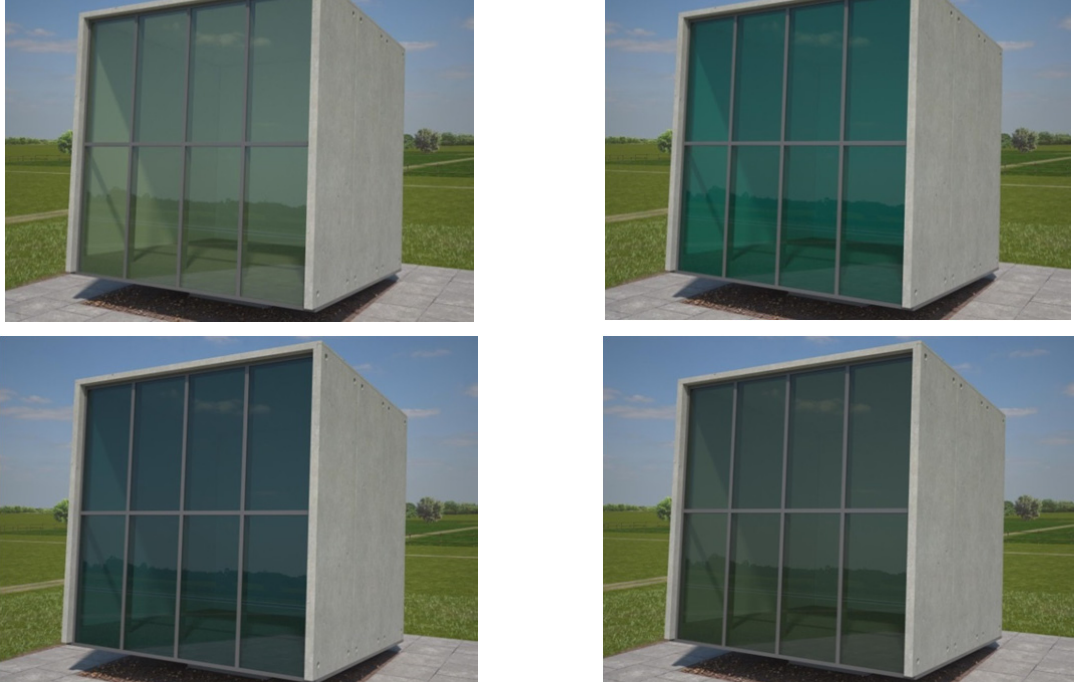
Fig. 6 Examples of different exterior color aesthetics in EC glazing (from top left to bottom right: Classic, Green, Blue, Gray).